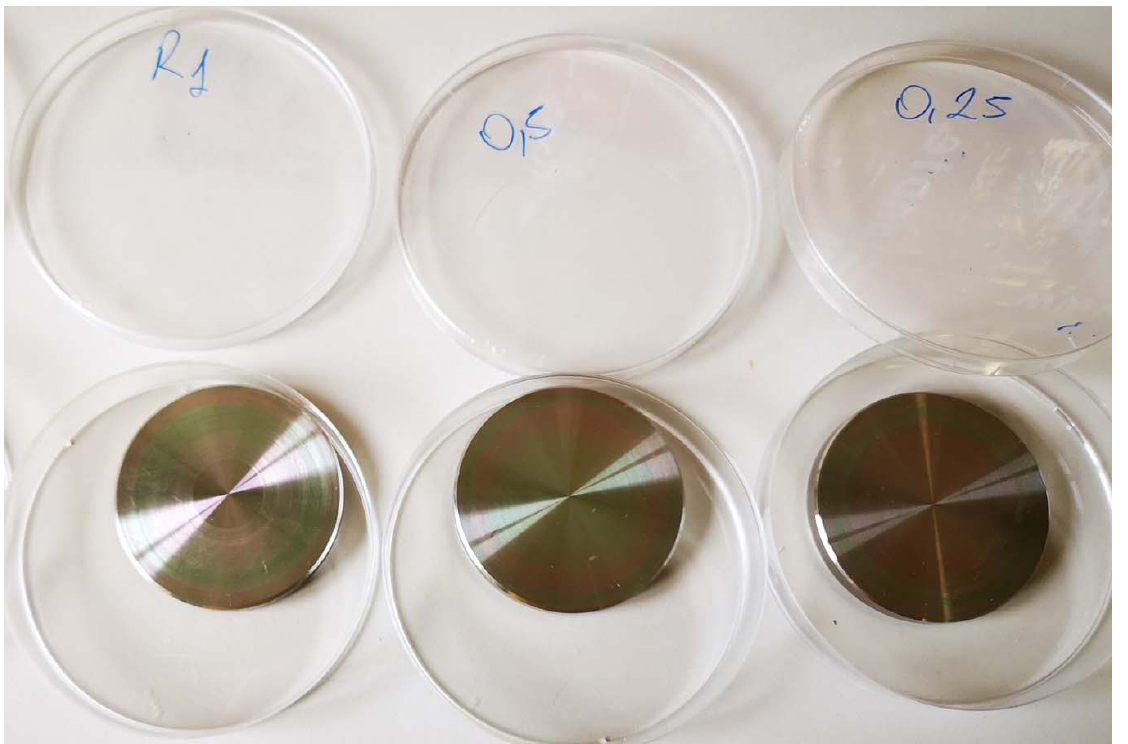
Figure 1. Representative image of stainless steel disks with different roughness, R 0.25, R 0.5, and R 1 μ m treated nanoXHAM ® D.